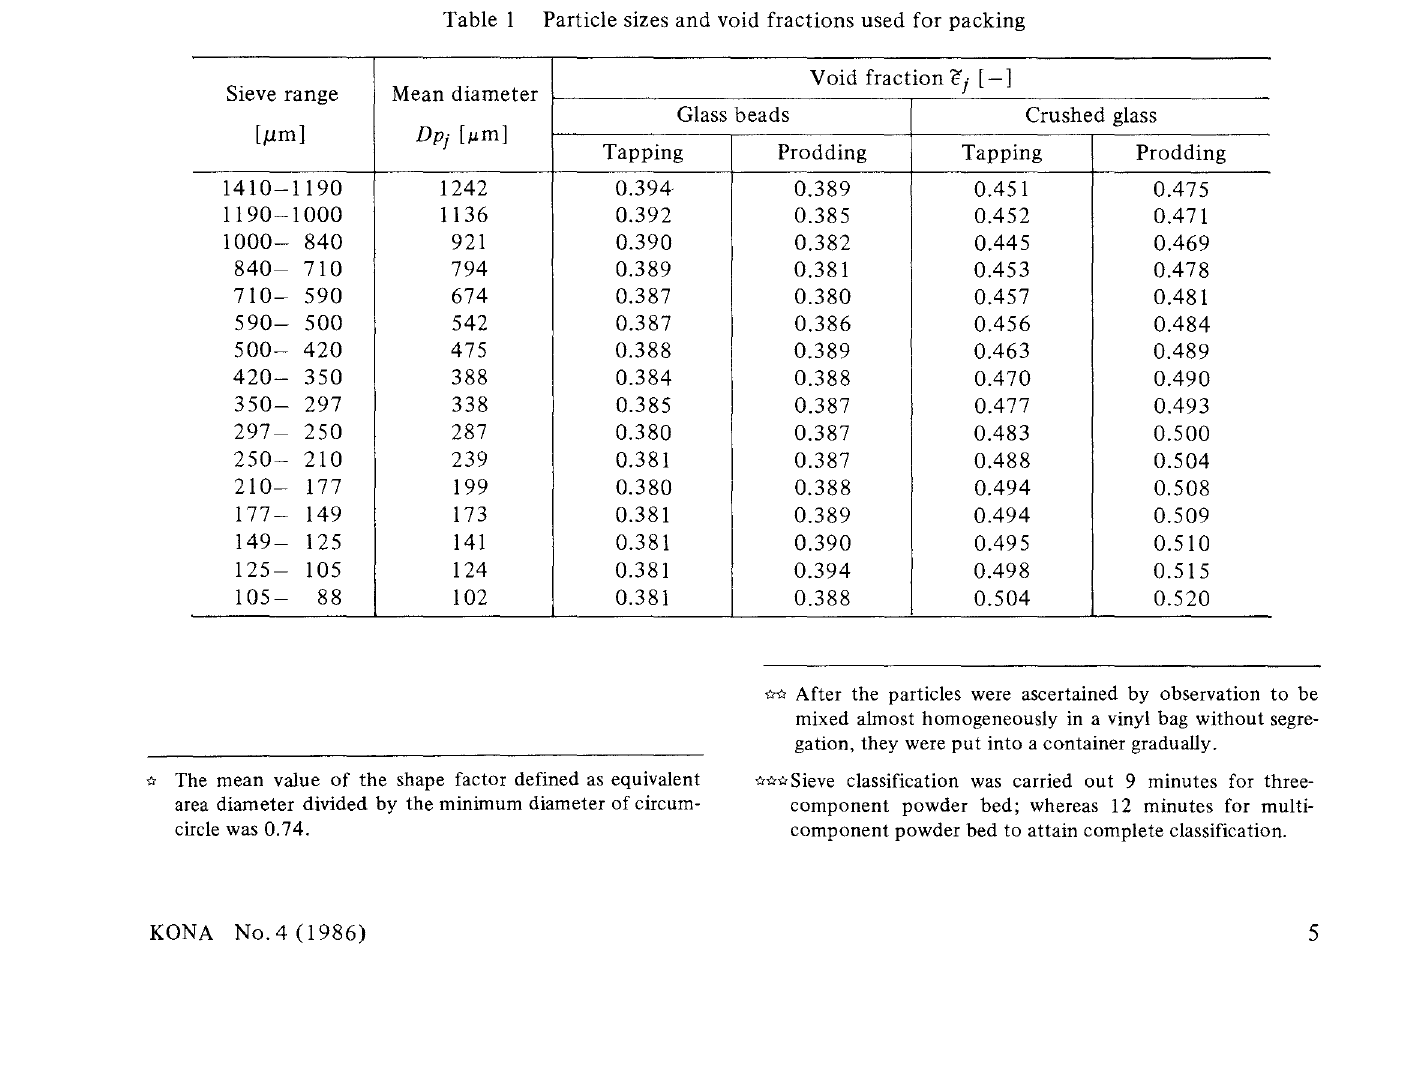
Particle sizes and void fractions used for